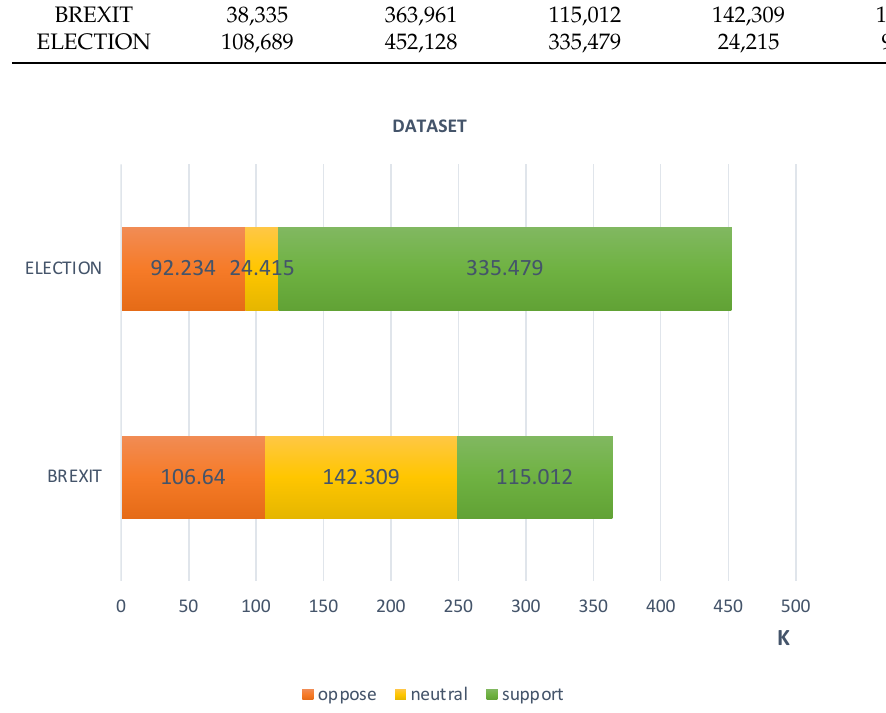
Figure 4. The number of tweets classified as support, neutral and